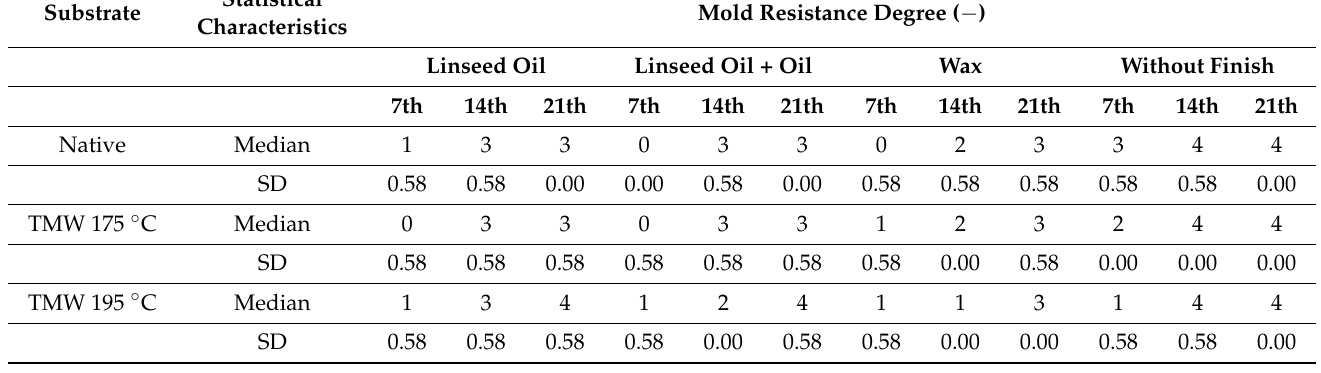
Table 10. Resistance of the surface finishes to mold during 0–21 days of mold test.